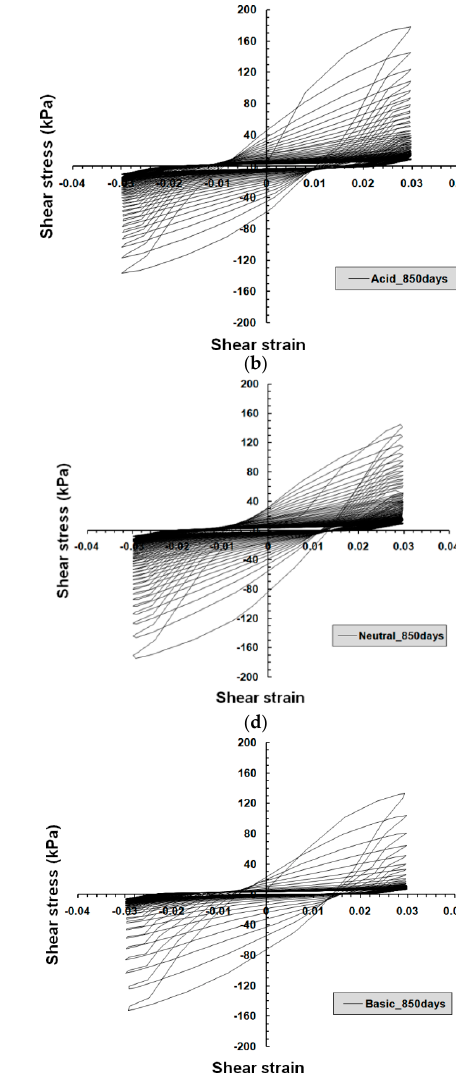
Figure 6. Typical shear stress–strain curves for the 850-day submersion period: ( a , c , e ) = 0.3 MPa of normal stress; and ( b , d , f ) = 0.6 MPa of normal stress.